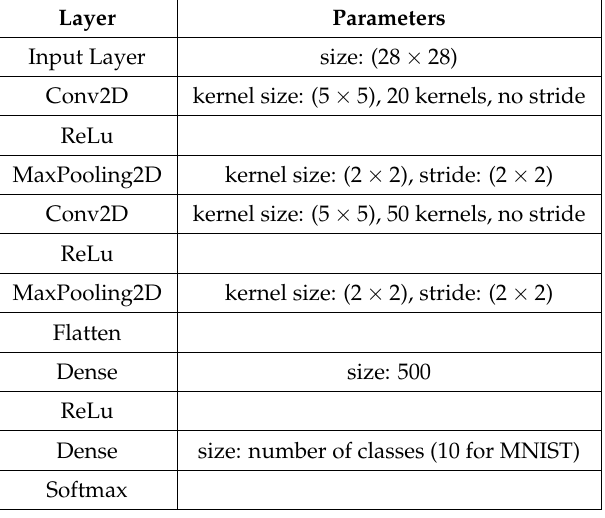
Table A1. Architecture of the used NNC on MNIST (LeNet-5 inspired)